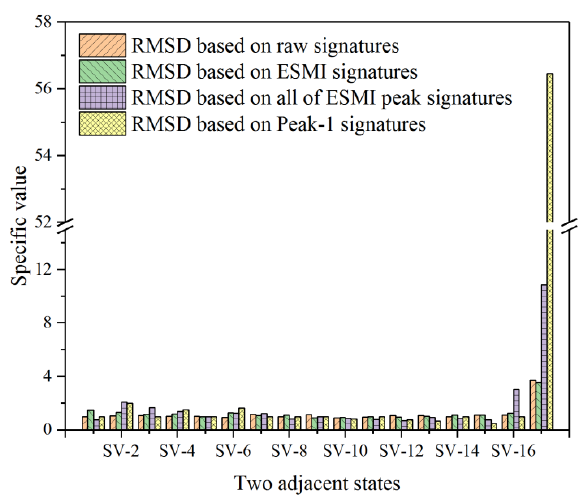
Figure 9. Histogram of specific values of two adjacent RMSD bars based on real part